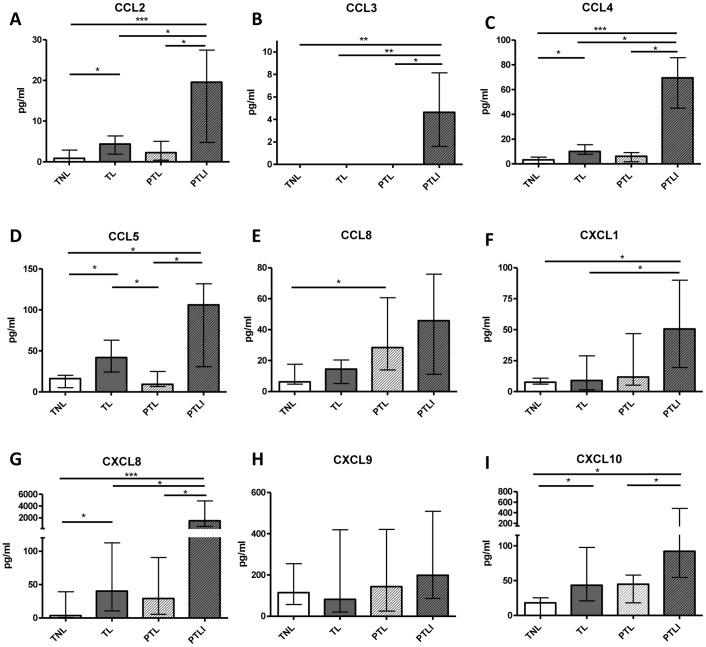
Concentrations of chemokine protein (pg/ml) in choriodecidual tissue lysates in the four study groups.(A) CCL2, (B) CCL3, (C) CCL4, (D) CCL5, (E) CCL8, (F) CXCL1, (G) CXCL8, (H) CXCL9, (I) CXCL10. Individual replicates and the median are shown, n = 10/study group. TNL = Term not in labour, TL = Term labour, PTL = Preterm labour and PTLI = Preterm labour with infection. Data are median and interquartile range, *p<0.05, **p<0.01, ***p<0.001 (Kruskall-Wallis with Dunn’s post hoc test).